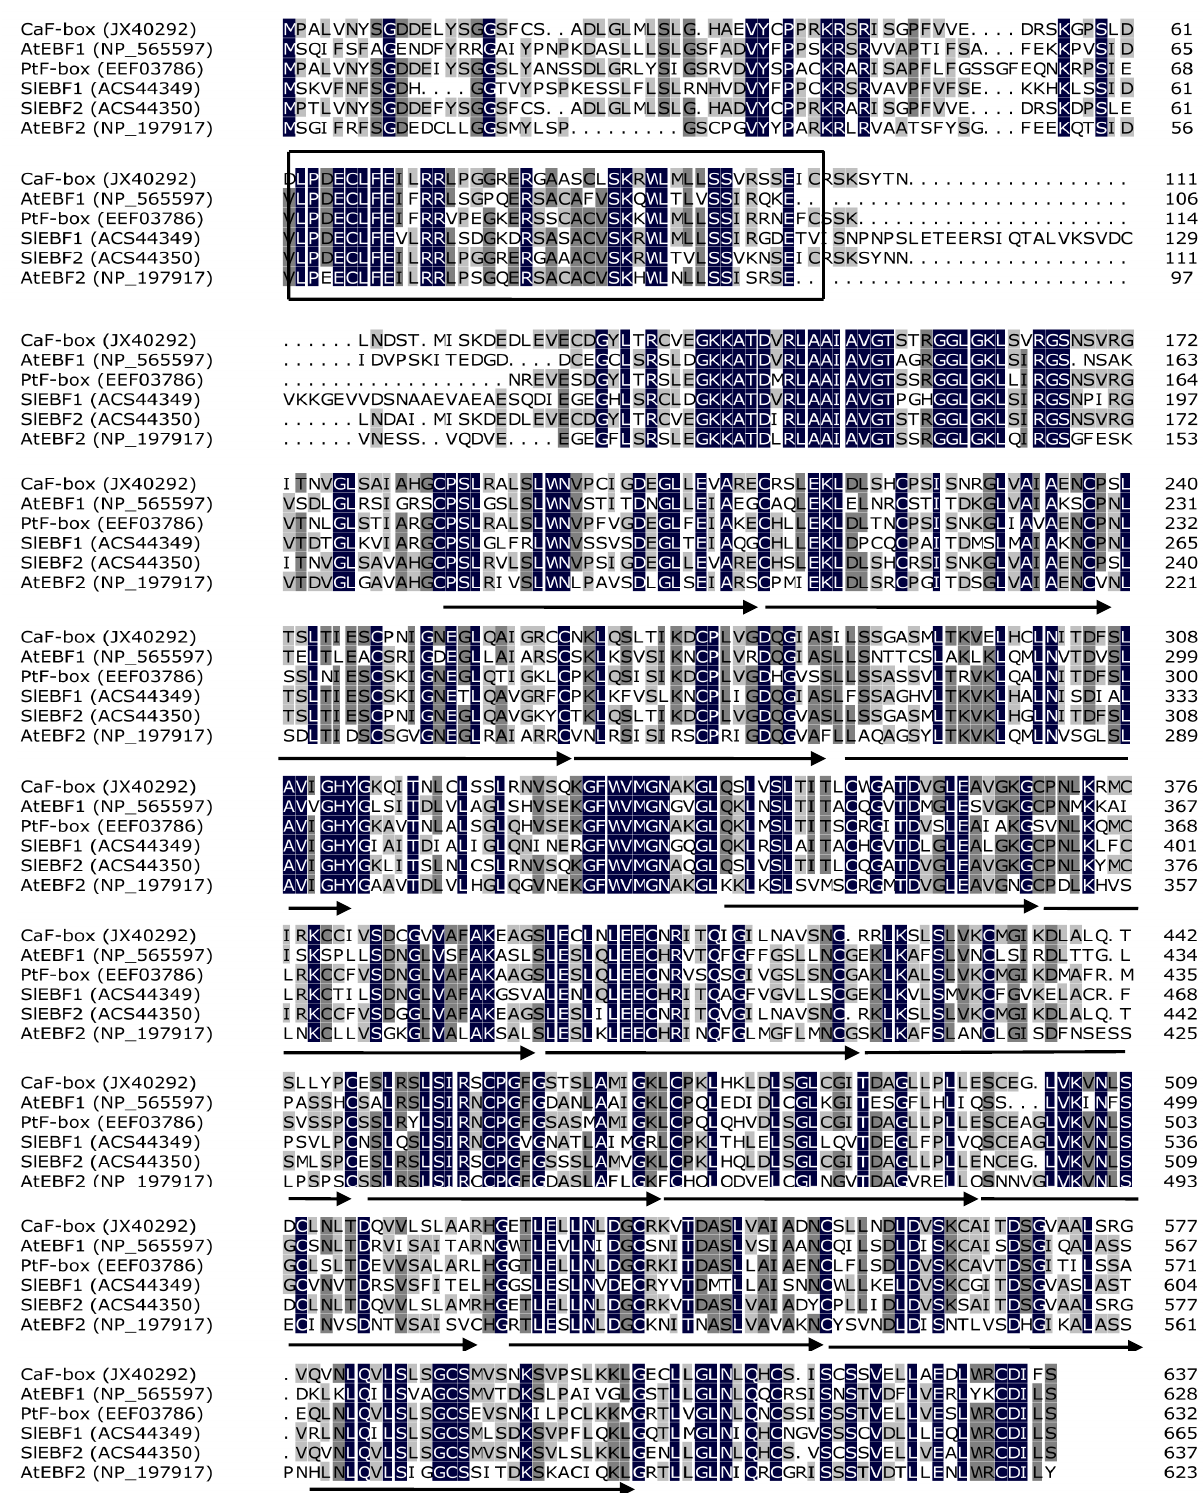
Figure 1. Multiple sequence alignment of CaF-box with the amino acid sequences of Arabidopsis thaliana AtEBF1 and AtEBF2, Solanum lycopersicum SlEBF1 and SlEBF2, and Populus trichocarpa PtF-box. Putative F-box motif sequences are boxed, and the 15 deduced leucine-rich repeats (LRRs) are indicated by arrows under the